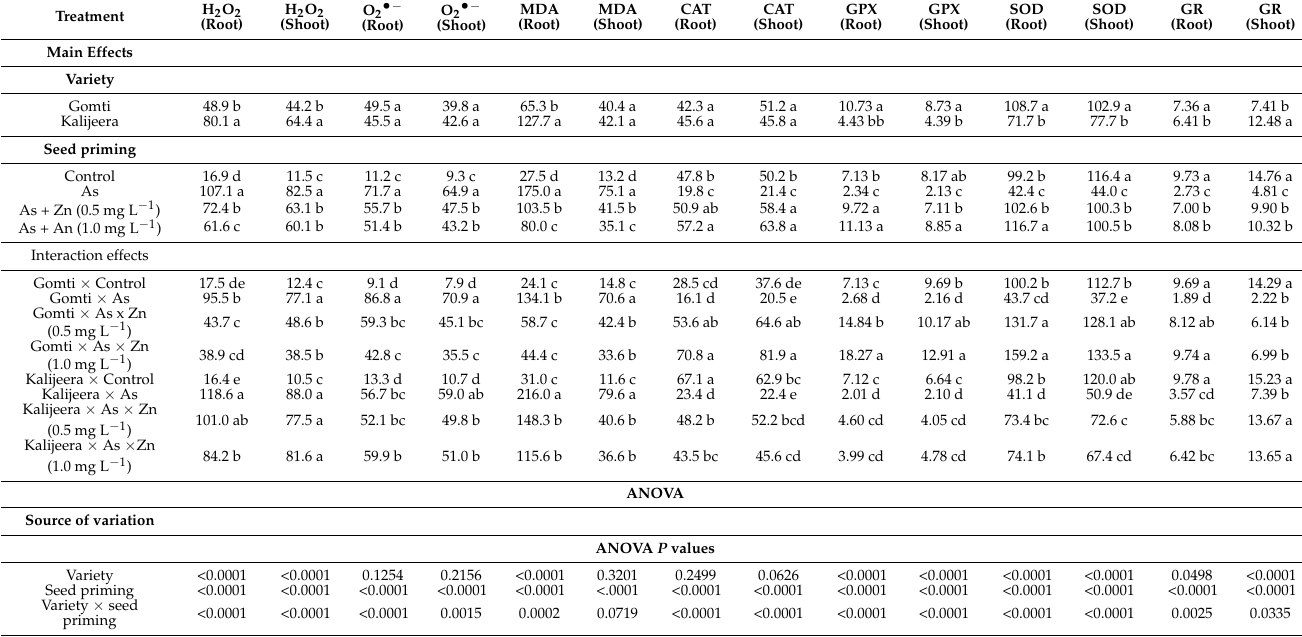
Table 2. Consequences of seed priming with Zn on seedling oxidative stress-induced biomarkers and enzymatic profile of rice seedling grown under As